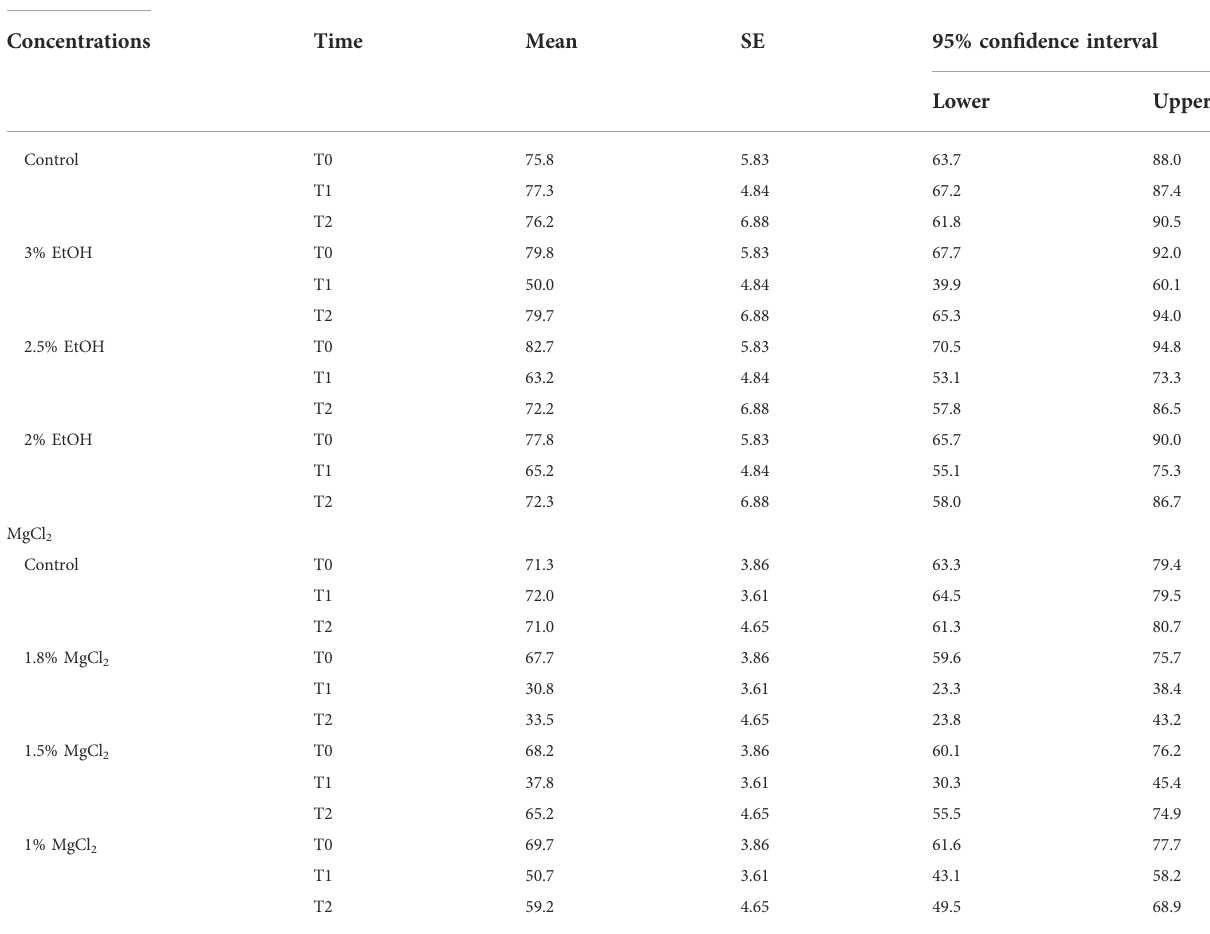
TABLE 1 Heart rate (beats/minute) of L. vulgaris embryos exposed to different EtOH and MgCl 2 concentrations and the controls (no anesthetic solution). Measures are summarized (mean, SE, and 95% con fi dence interval) at the three different phases: baseline, t0; anesthesia, t1; and recovery,